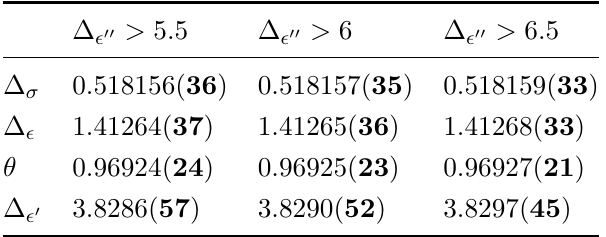
Table 5 . The three columns show the allowed interval found at Λ = 19 under the assumptions ∆ 5 . 5 , 6 and 6 . 5 respectively. The error presented in bold is rigorous. The upper bound is (cid:15) 00 > completely stable under a change of the position of the gap while the lower bound shows some very minor